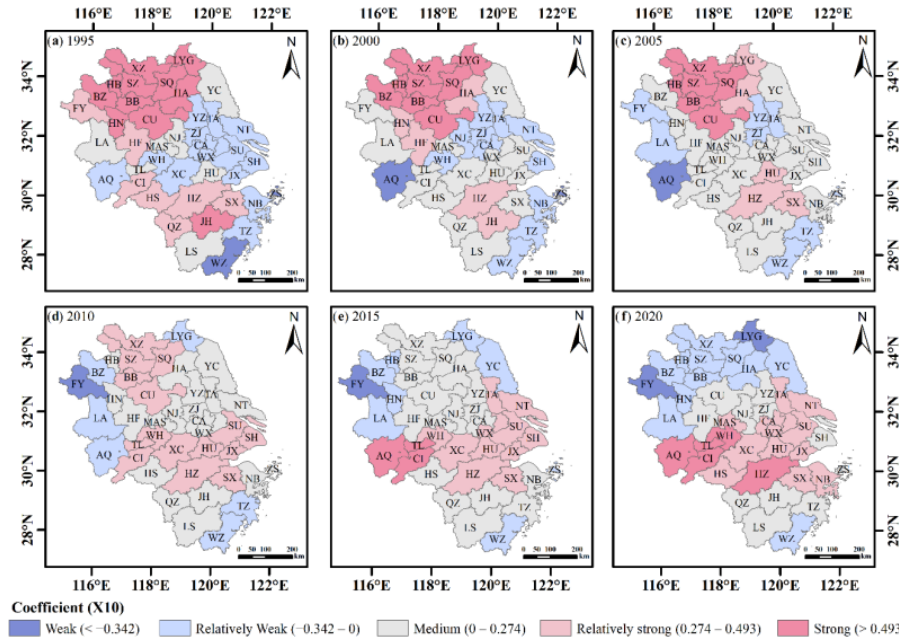
Figure A10. Spatial distribution of the regression coefficients of the normalized vegetation index.